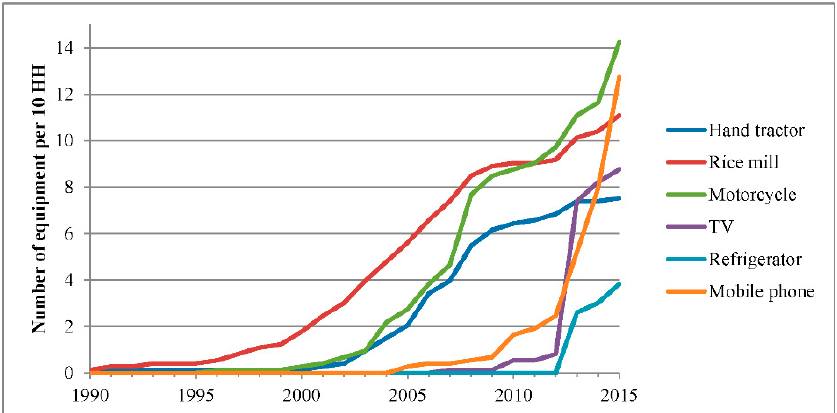
Figure 6. Time of equipment purchase by households (HH) in the study area (cumulative values).